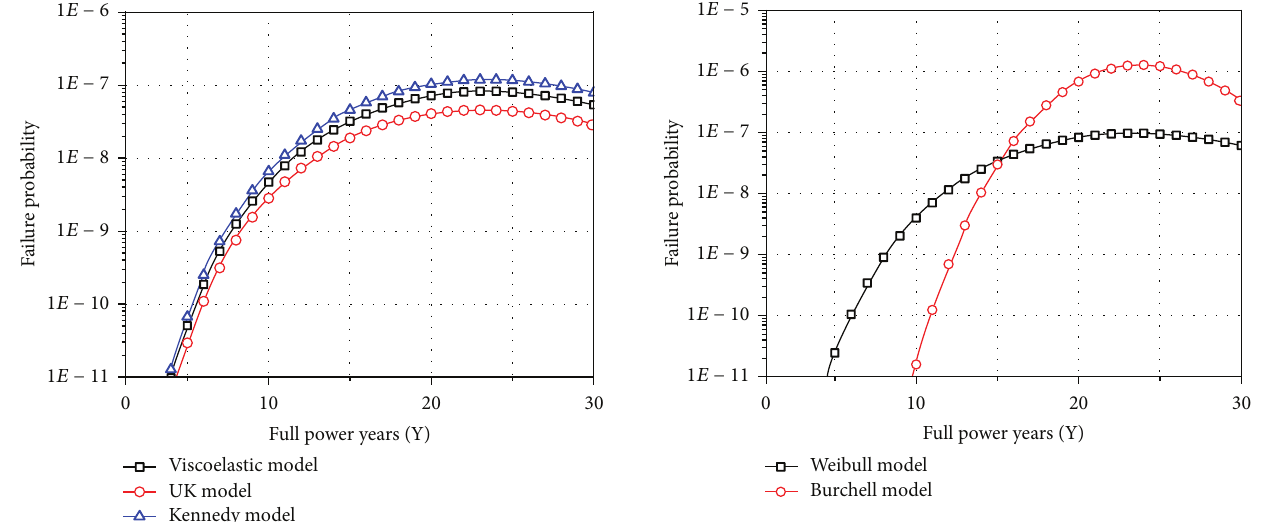
Figure 7: Failure probability history of ATR-2E graphite brick.